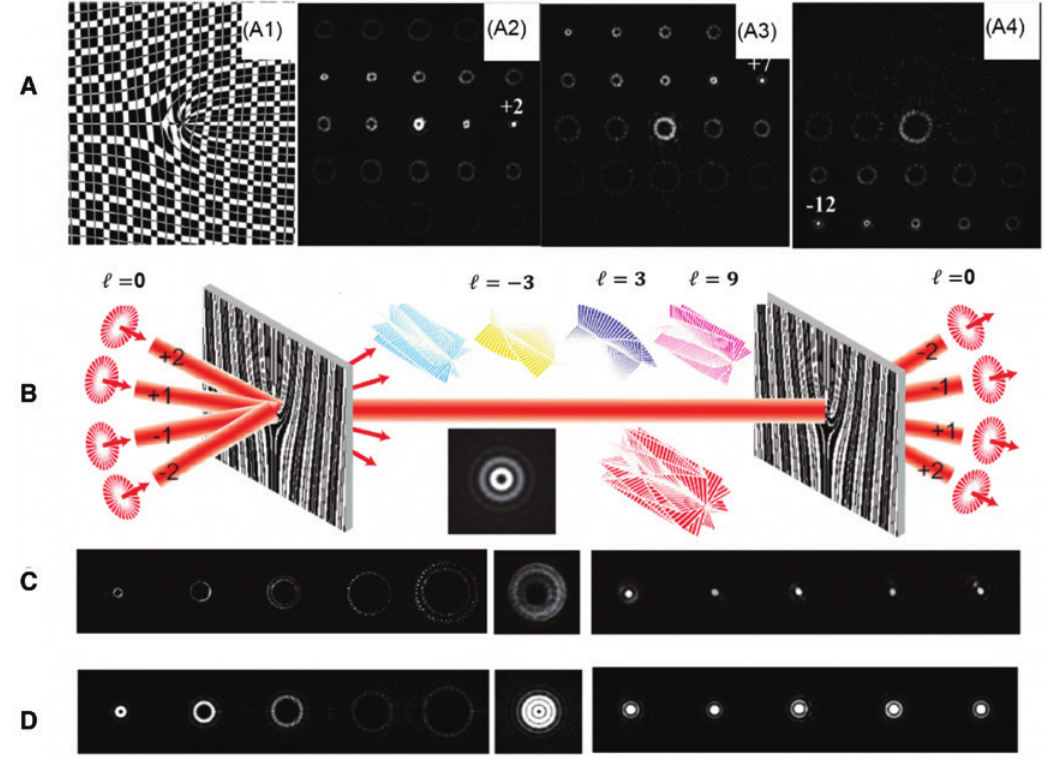
Figure 10: OAM multiplexing via Dammann gratings. (A1) Phase pattern of 2D Dammann vortex grating (black for 0 and white for π ); (A2)–(A4) optical vortex with various topological charges (−2, −7, and 12) detection by the Dammann vortex grating. Reprinted from Ref. [217]. (B–D) Schematic of OAM-based free-space optical communications using the Dammann optical vortex grating for multiplexing/demultiplexing. Reprinted from Ref.